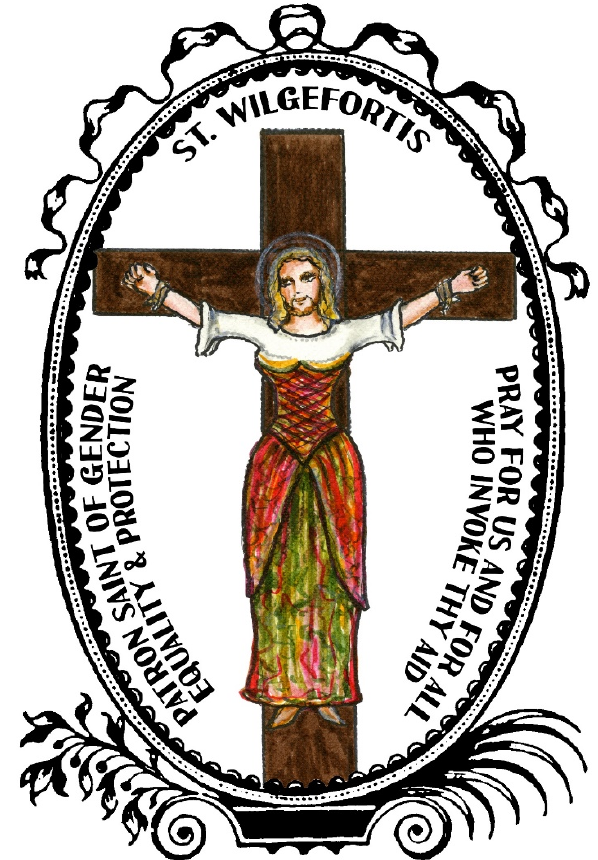
Figure 6. St. Wilgefortis (2015) by Shoushan. Photo Credit: Image used with author’s